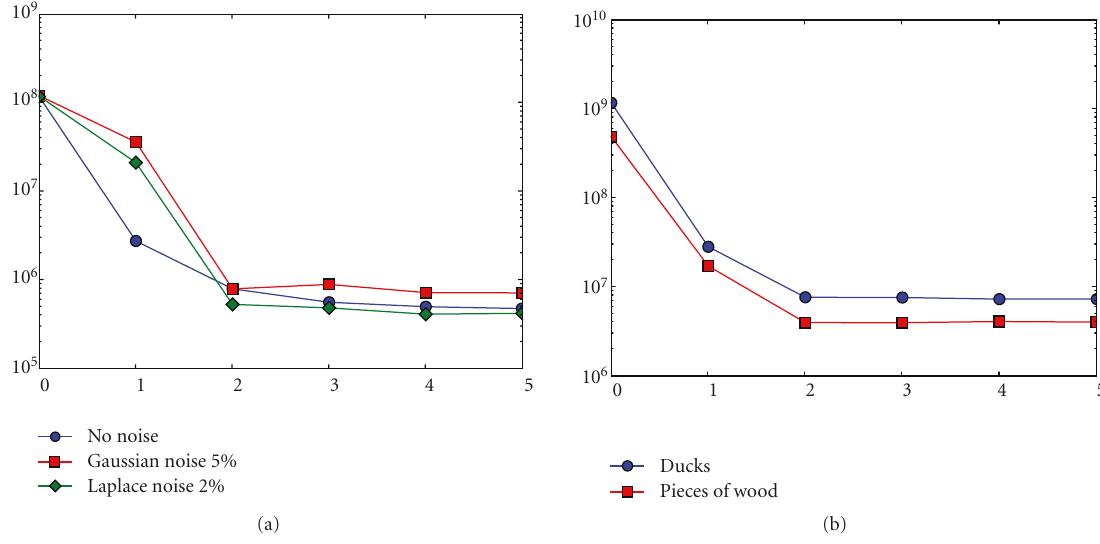
Figure 5: (a) Scree plots for S P on the SwissRoll, (b) the duck and the piece of wood from the COIL-20 database. The abscissa axis is the dimension of the reduced space; and the ordinate axis is the value of the cost function at the solution.